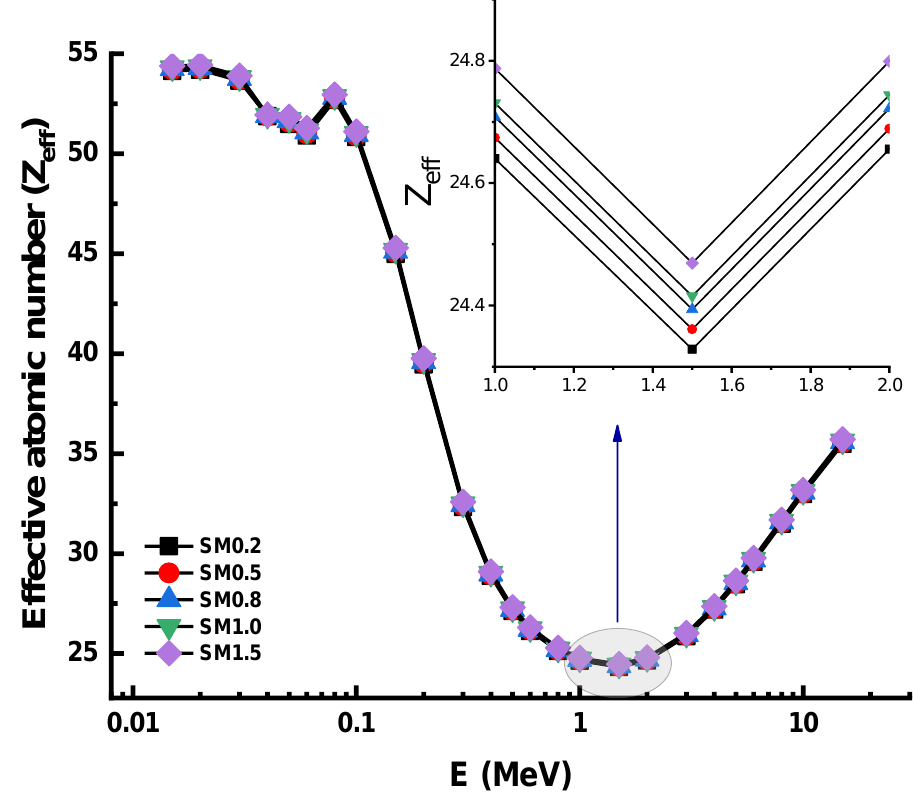
Figure 8. Variation of effective atomic number (Z eff ) against Photon energy for all glasses. The buildup factor is a correction factor used in shielding computations to account for the effect of scattered radiation and any secondary particles in the medium. If one intends to compensate for secondary radiation accumulation, one must add a buildup fac- tor. The accumulation factor is thus a multiplicative factor that incorporates the contribu- tion of the scattered photons into the reaction to the uncollided photons. Thus, the accu- mulation factor may be calculated as the ratio of the entire dosage to the uncollided dose- response [27]. Meanwhile, the term of buildup factor can be classified as to exposure buildup factor (EBF) and energy absorption buildup factor (EABF) [28]. In parallel to the given description, the lower buildup factor values can be considered a superiority pattern against gamma-rays since the uncollided photon amount in the successful shields would be low. Figures 9 and 10 depicts the variations of EBF and EABF values as a function of energy at various mean free paths (i.e., from 0.5 to 40). The highest values were seen in both EBF and EABF in the mid-energy range, where Compton scattering is the main in- teraction between the gamma-ray and the material (see Tables S1 – S5). In other words, this area has a high amount of uncollided photons. As a result, relatively higher values for the buildup factor are required to correct the transmission calculations. Our results indicate that SM1.5 has the lowest accumulation factors in both EBF and EABF. Thus, incoming gamma-rays may interact with the SM1.5 sample more often than with other samples.